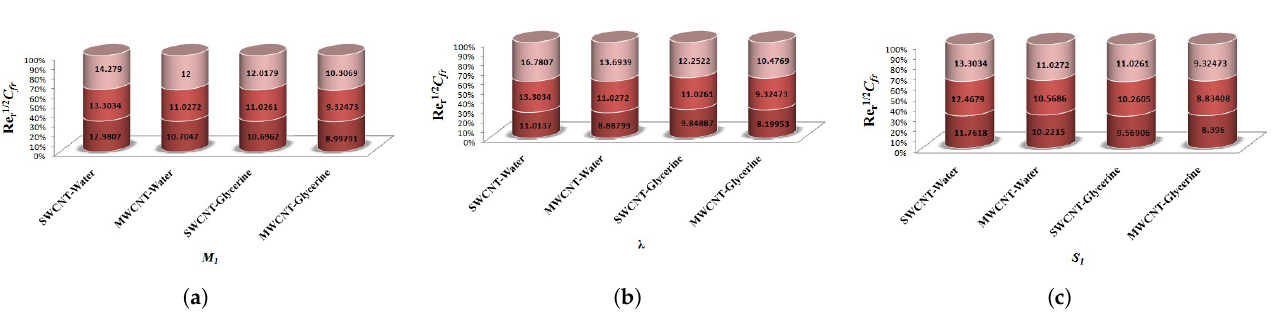
Figure 26. Impact of M 1 , λ , S 1 on Skin-Friction.